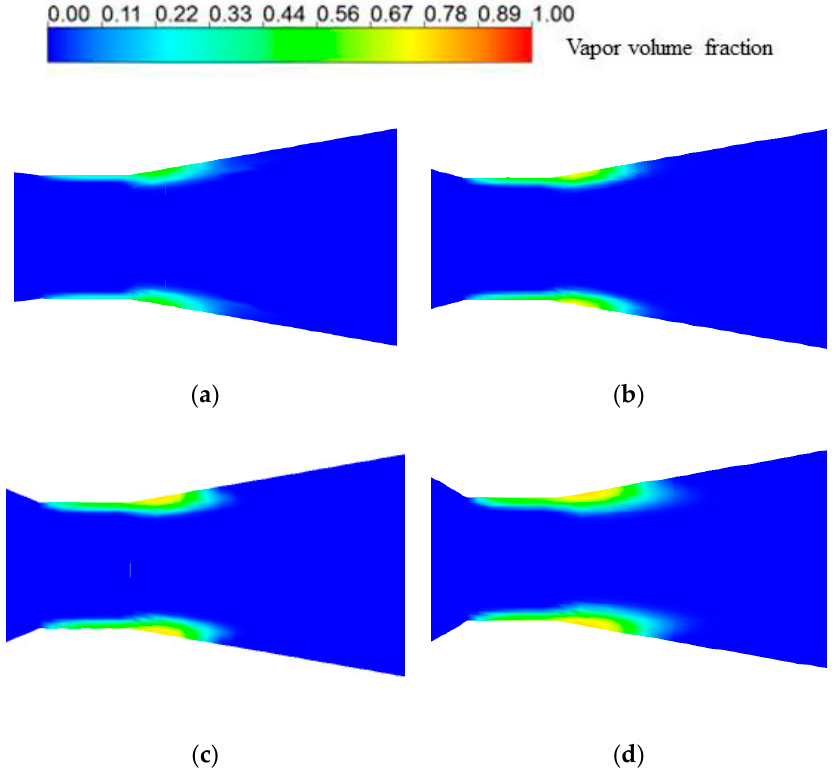
Figure 7. Contour of vapor volume fraction in the throat and the diffusion section with different contraction angles, ( a ) 15°, ( b ) 30°, ( c ) 45°, ( d ) 60°.